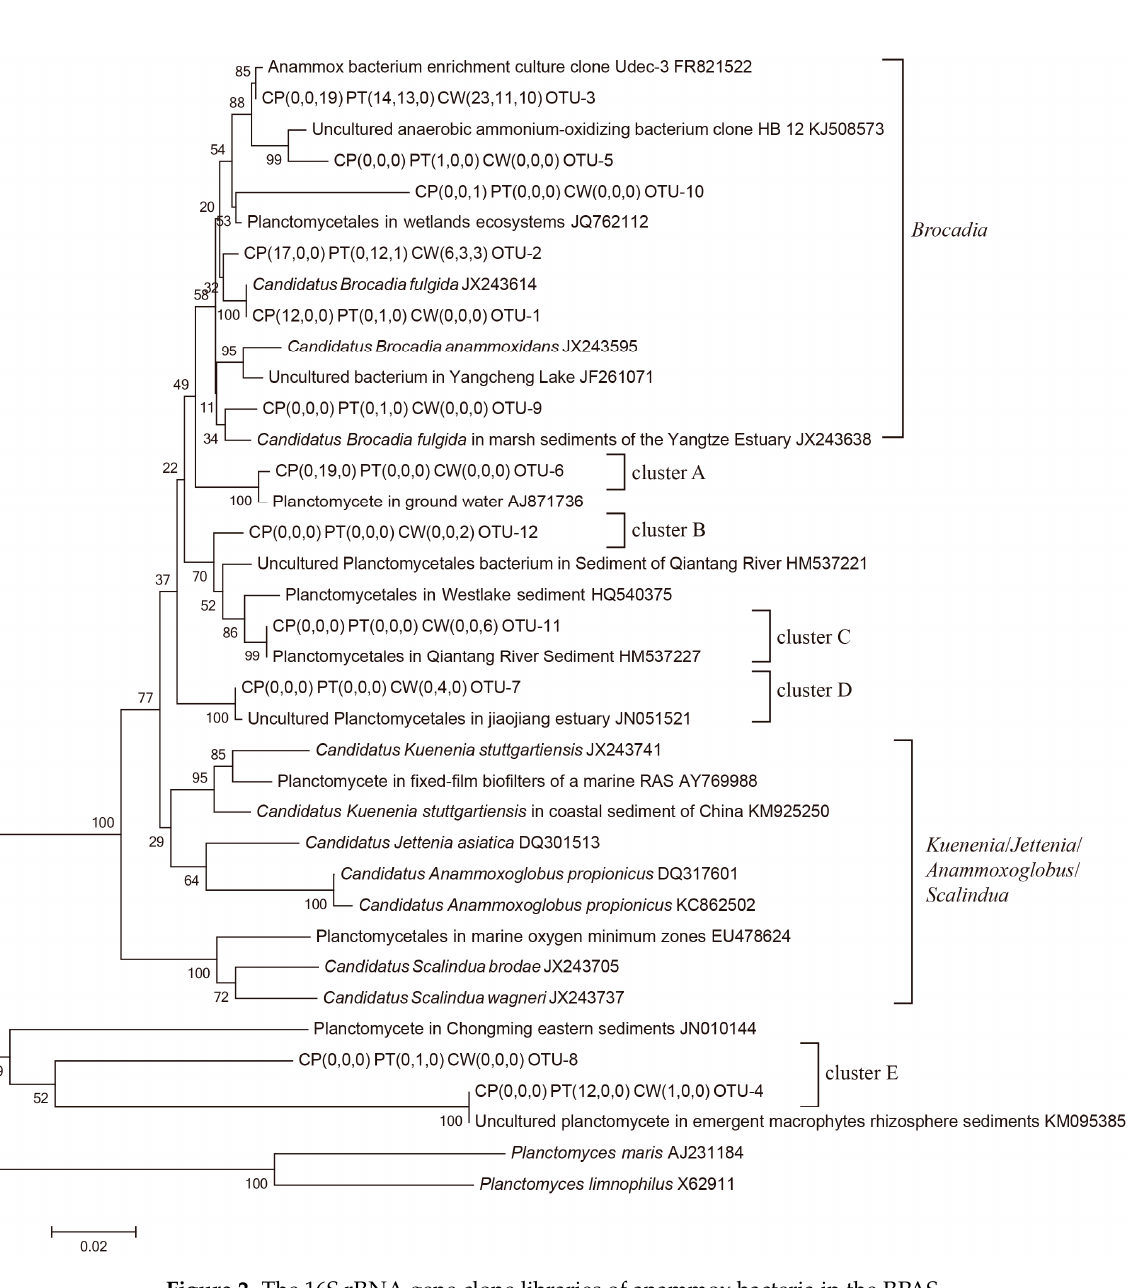
Figure 2. The 16S rRNA gene clone libraries of anammox bacteria in the RPAS. Table 3. Relative abundance of the phylogenetic types based on the anammox 16S rRNA genes recovered from the RPAS. Total